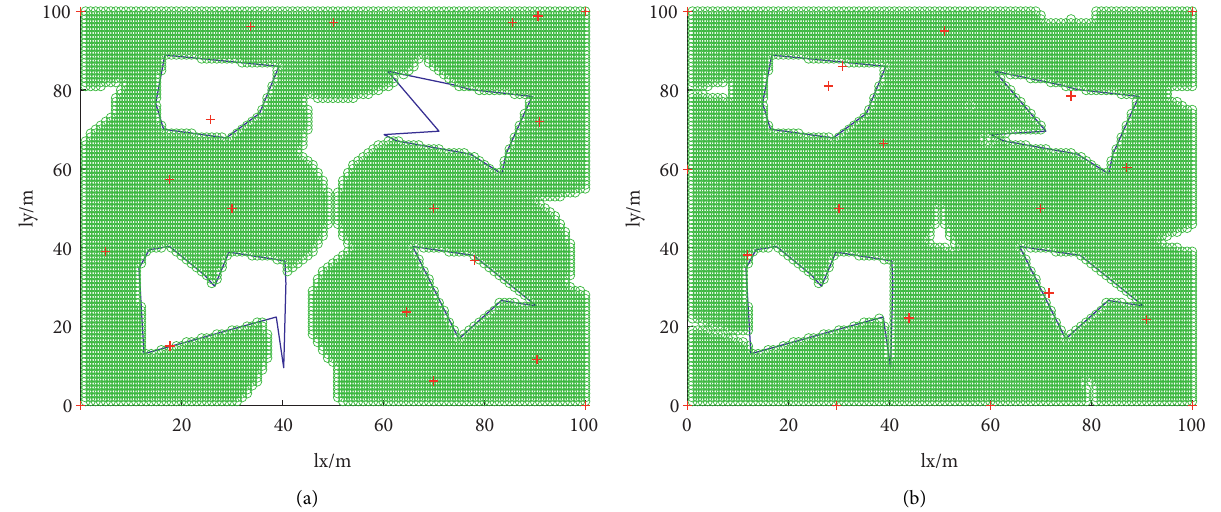
Figure 15: Network coverage of 13 nodes: (a) before optimization and (b) after optimization.